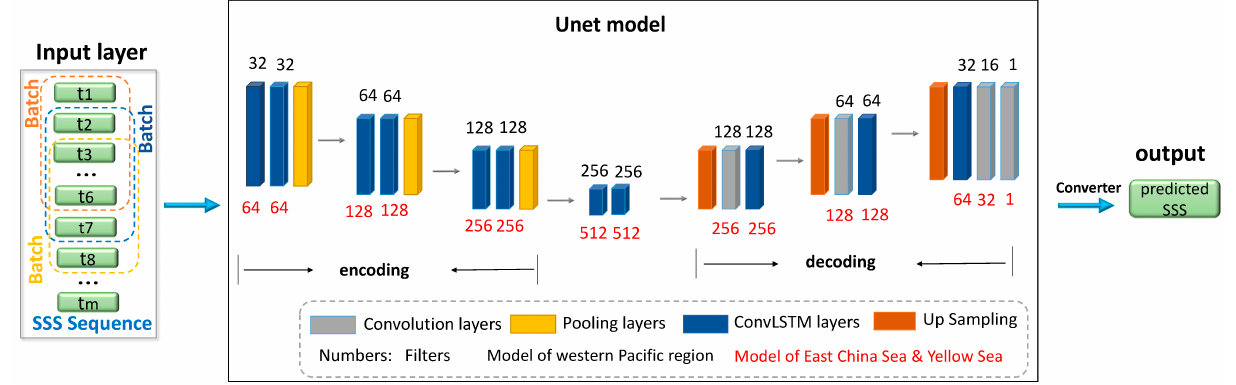
Figure 1. Structures of the modified U-net model and illustrative study fl ow.